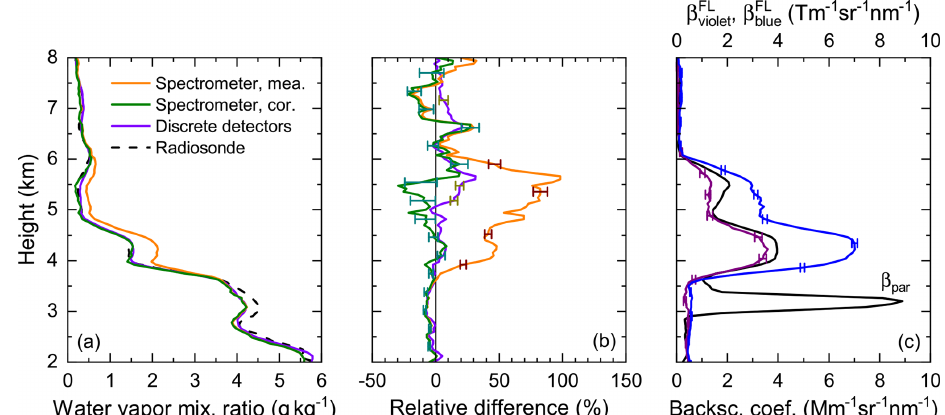
Figure 8. Effect of BBA fluorescence on water vapor mixing ratio measurements with RAMSES and its correction. Profiles of (a) water vapor mixing ratio as obtained with the UVA spectrometer (uncorrected and corrected for aerosol fluorescence) and discrete detectors (uncorrected), (b) relative difference between RAMSES and radiosonde water vapor mixing ratios, and (c) particle backscatter coefficient ( β par ) and mean violet and blue fluorescence spectral backscatter coefficients ( β FL and β FL ) measured on 9 August 2021 at 22:58UTC. The humidity violet blue profile of the routine midnight radiosonde launched on site at 22:48UTC is shown for comparison (panel a ). Bars indicate statistical errors of the lidar